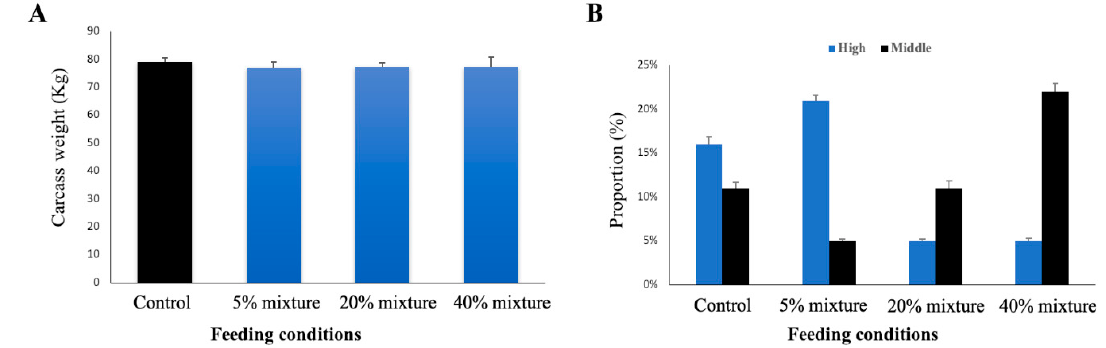
Figure 8. Carcass weight ( A ) and carcass quality ( B ) of different groups of study pigs at slaughtered at 24 weeks of age. Results presented are the mean ± SD of three independent